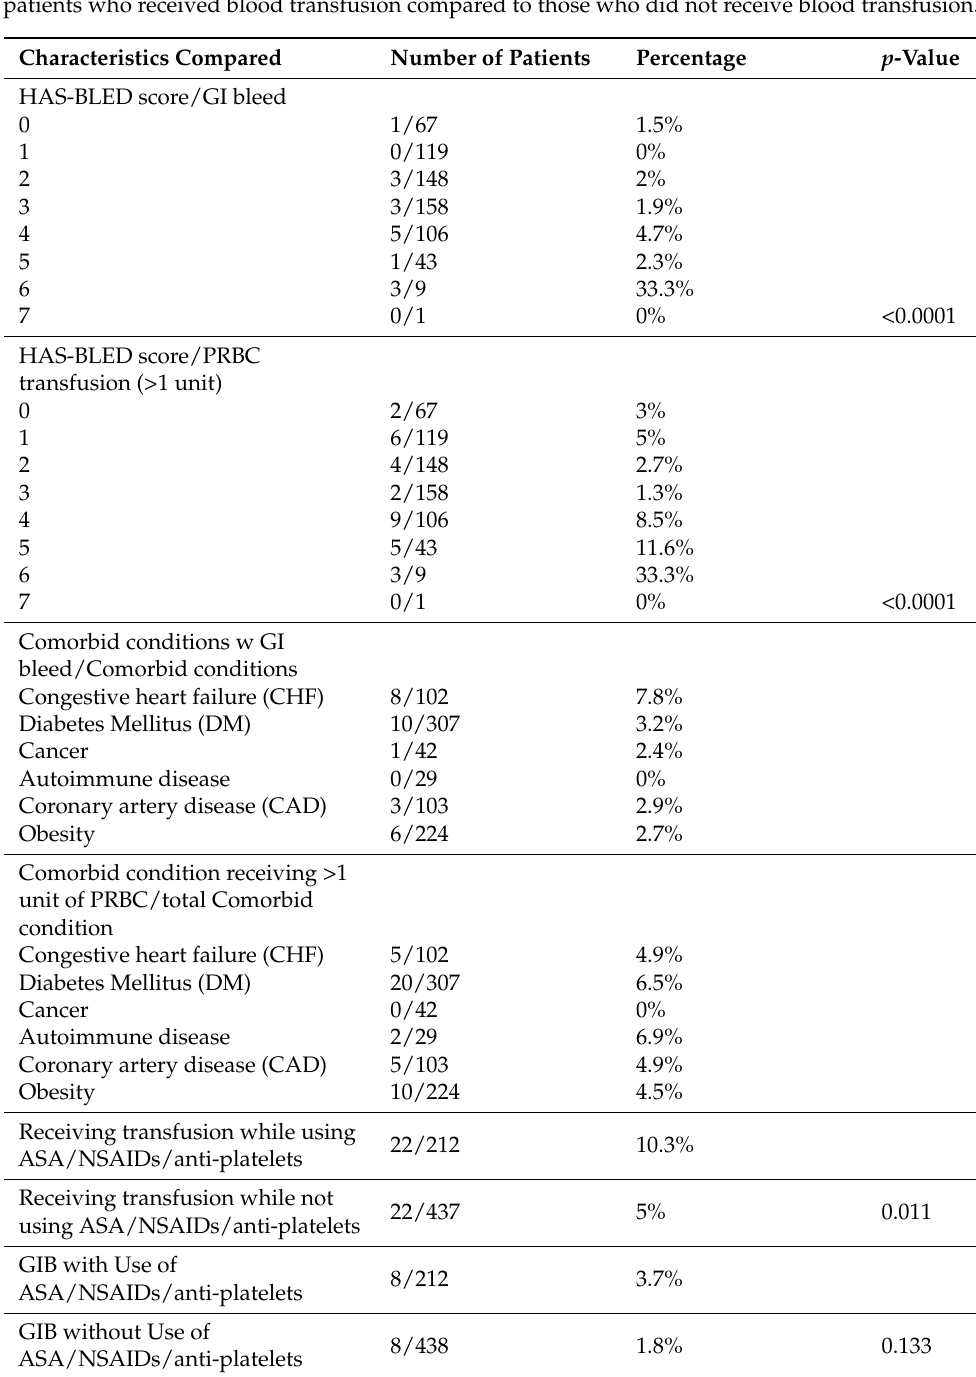
Table 2. Characteristics used to compare GIB patients with non-GIB patients and also used to compare patients who received blood transfusion compared to those who did not receive blood